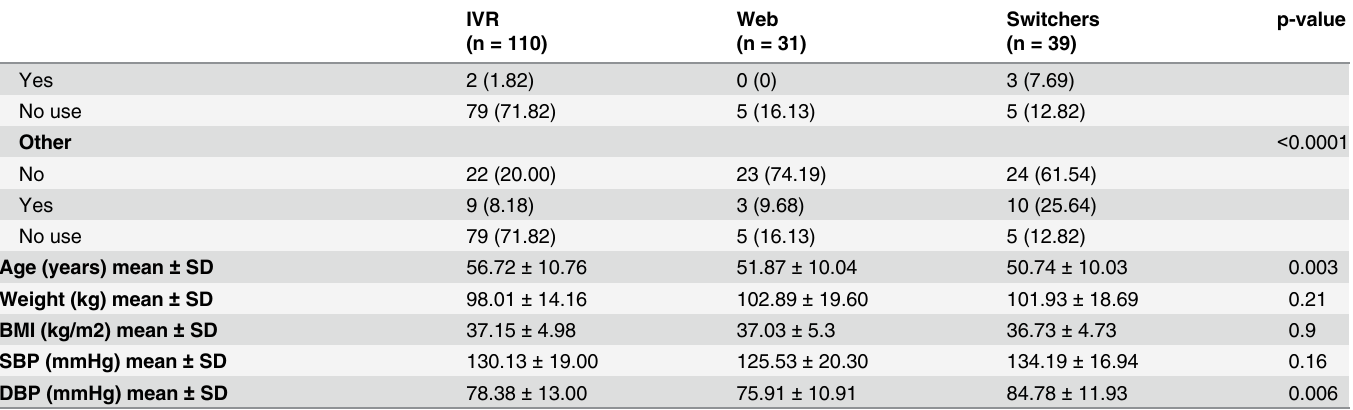
likely to decrease IVR self-monitoring as compared to those with the lowest health literacy (p = 0.04). Participants who used mobile phones to access the Internet had a significantly more rapid decrease in self-monitoring than those who did not (p < 0.0001). For participants using the web page to self-monitor, higher health literacy (p = 0.07), having (p = 0.004) were associated with a less rapid decline in rates of self-monitoring. Hispanic eth- nicity (vs. non-Hispanic/Black, p = 0.004) and being retired (p = 0.06) or disabled (p < 0.001) were associated with a more rapid decline in self-monitoring. Baseline weight was also inversely associated with web-based self-monitoring (p = 0.01); those with a higher weight were on average more likely to decrease frequency of web-based monitoring. Compared to par- ticipants who use the Internet at home, those who did not saw a greater decline in web-based self-monitoring (p = 0.01). In contrast, participants who use the Internet at work for personal matters were more likely to continue self-monitoring over time as compared to those who did not use the Internet at work (p = 0.03).